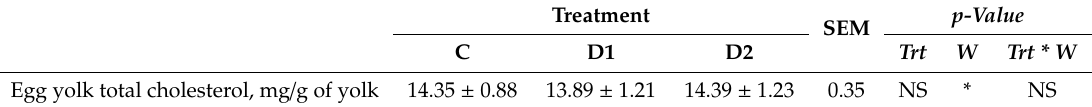
Table 8. E ff ect of dietary incorporation of spirulina on egg yolk cholesterol concentration.